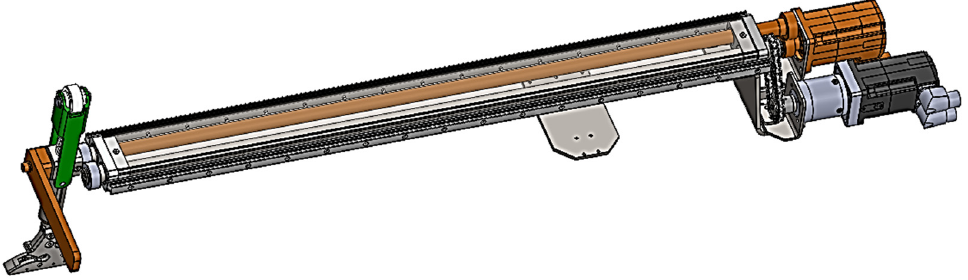
Figure 13. Mechanism responsible for rotating the reel bar.